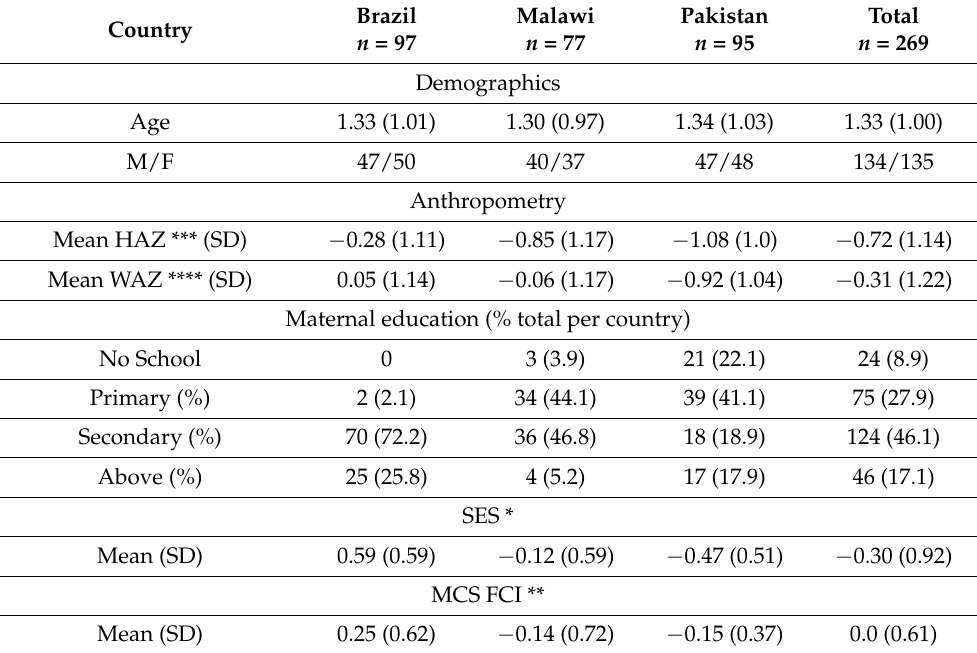
Table 2. Demographic features of children in IYCD sample across countries. Country